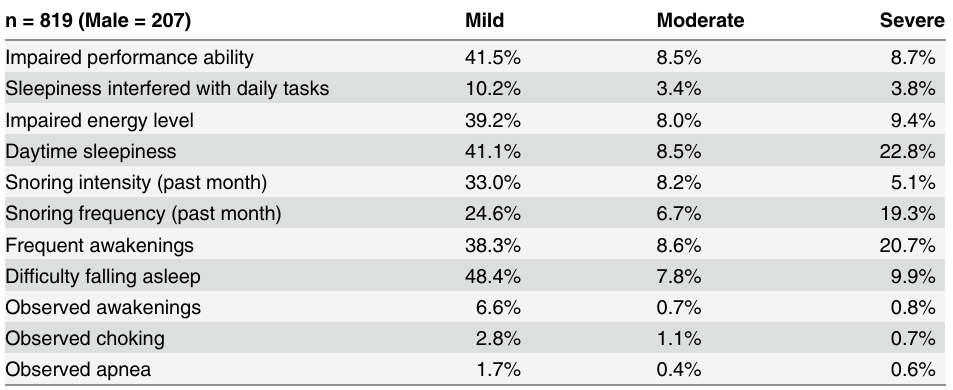
Table 2. Responses to selected questions from the Sleep & Health Questionnaire. [18]